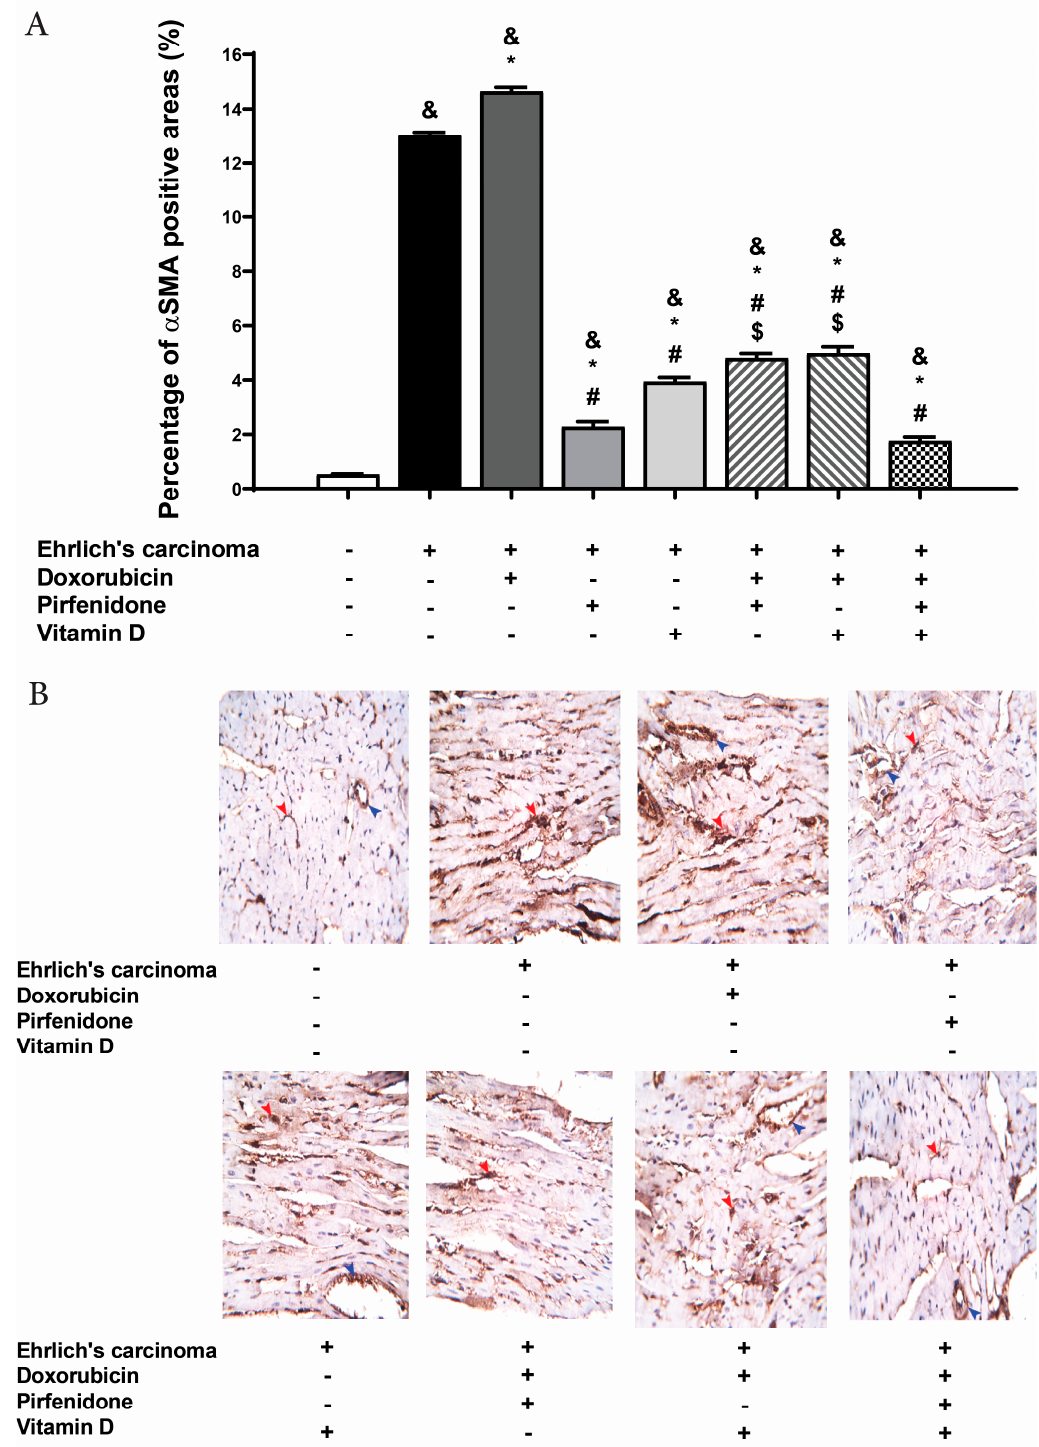
Figure 4. Effect of individual treatment with doxorubicin (15 mg/kg; i.p.), pirfenidone (500 mg/kg; p.o.) or vitamin D (0.5 μ g/kg; i.p.) and their combinations on the cardiac expression of α‐ SMA in EAC bearing mice on day 21. ( A ) A graph showing the density of immunostaining for α‐ SMA in experimental groups. ( B ) Photomicrographs showing cardiac expression of α‐ SMA. & p < 0.05 with respect to normal, * p < 0.05 with respect to control EAC, # p < 0.05 with respect to doxorubicin. $ p < 0.05 with respect to the co ‐ therapy of doxorubicin, pirfenidone, and vitamin D ( n = 5).